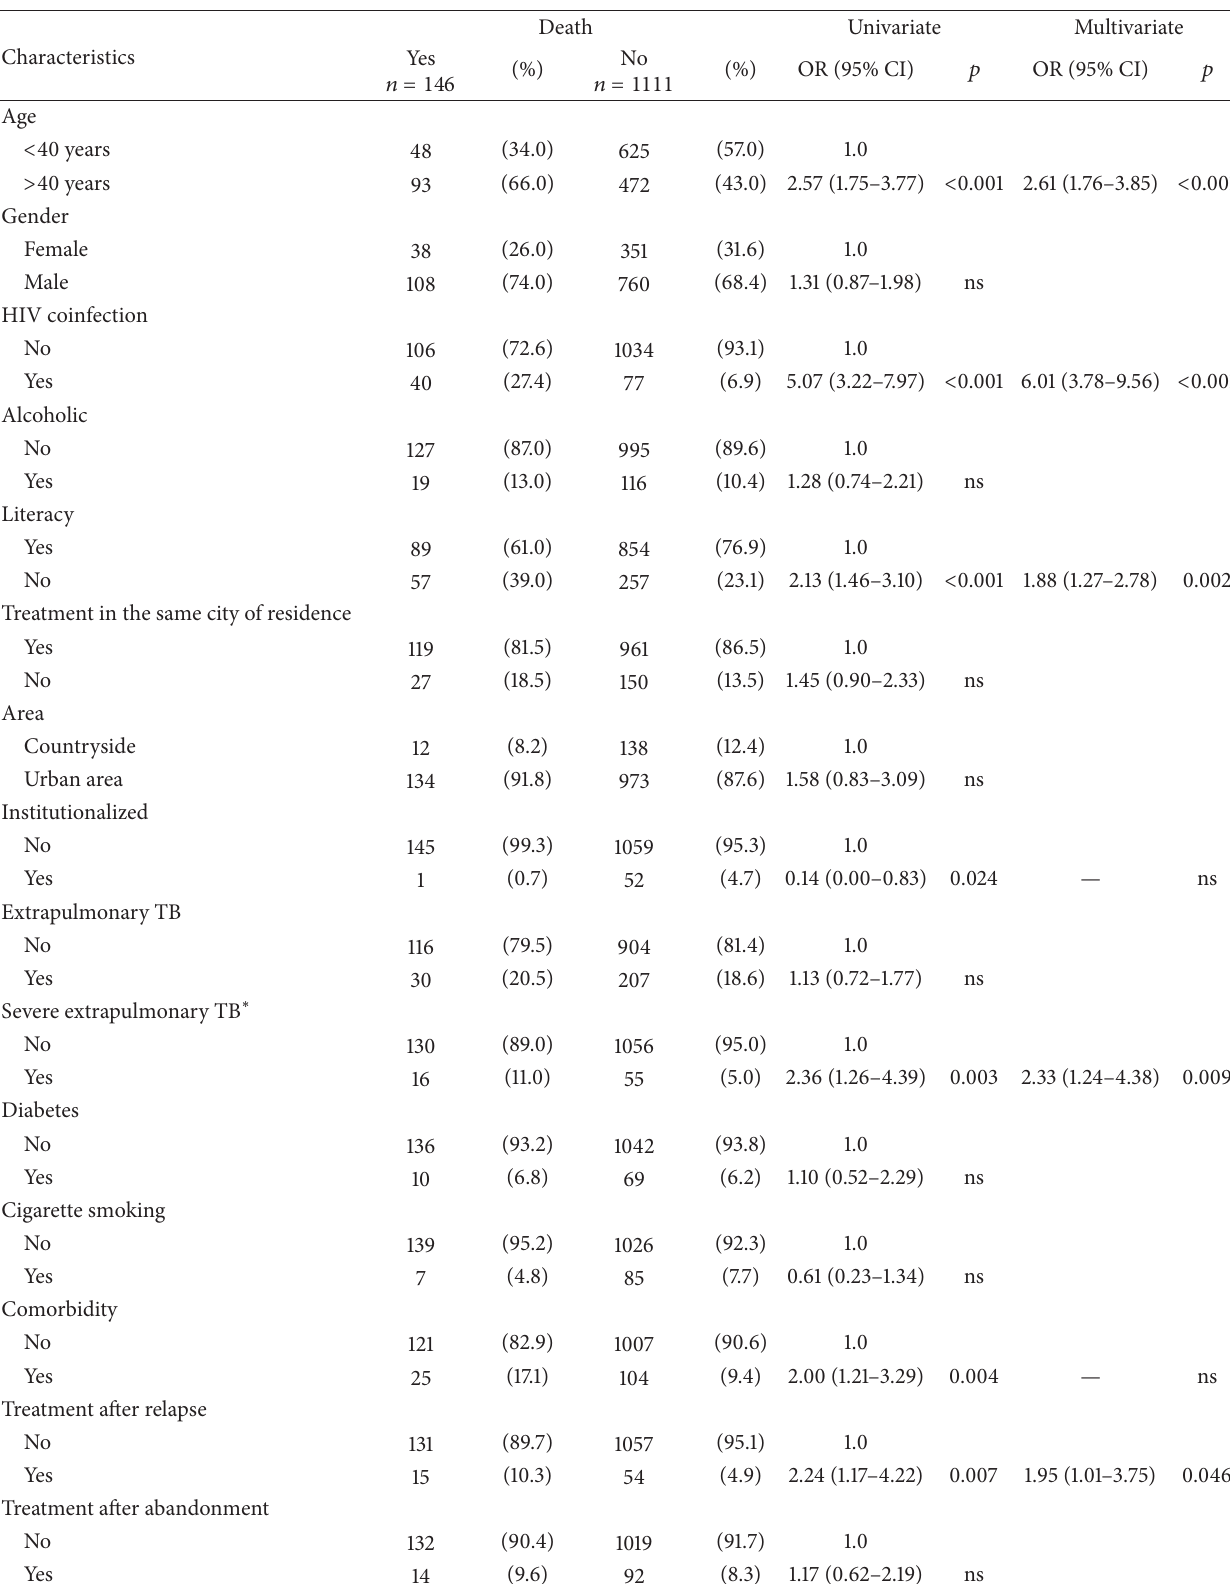
Table 3: Univariate and multivariate analyses of risk factors associated with death during TB treatment.